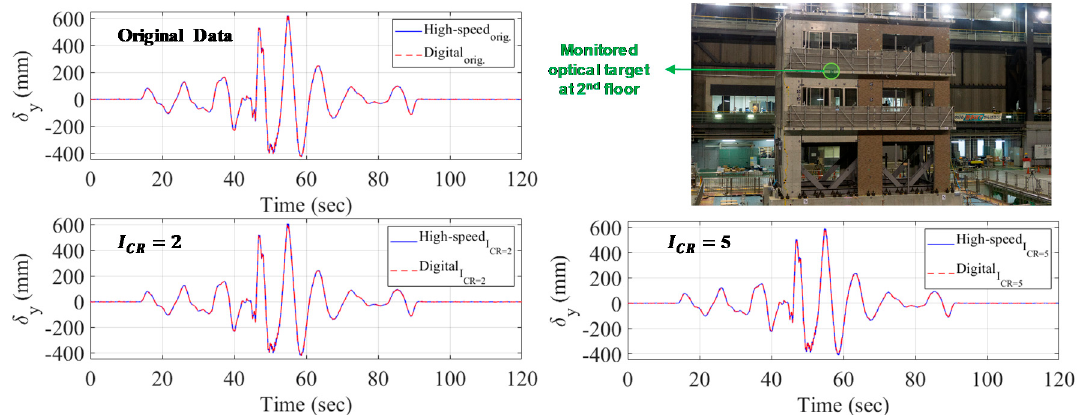
Figure 16. Displacement history from low-intensity seismic test as obtained from original and compressed images from two different vision-based systems (high-speed and digital cameras).